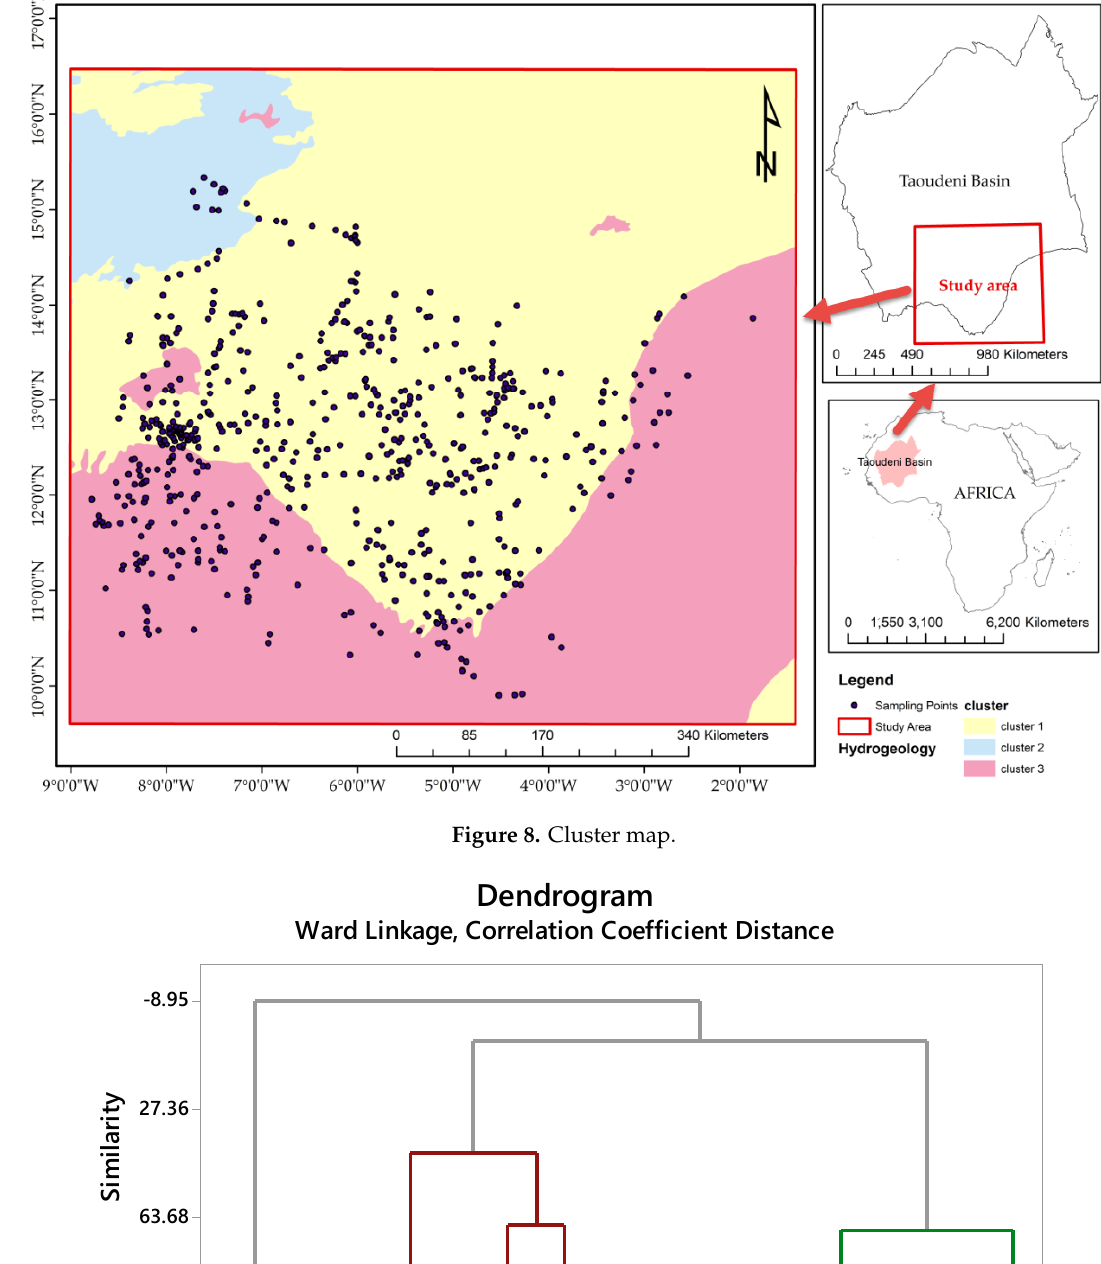
Figure 9. Dendrogram of the variables in the study area.